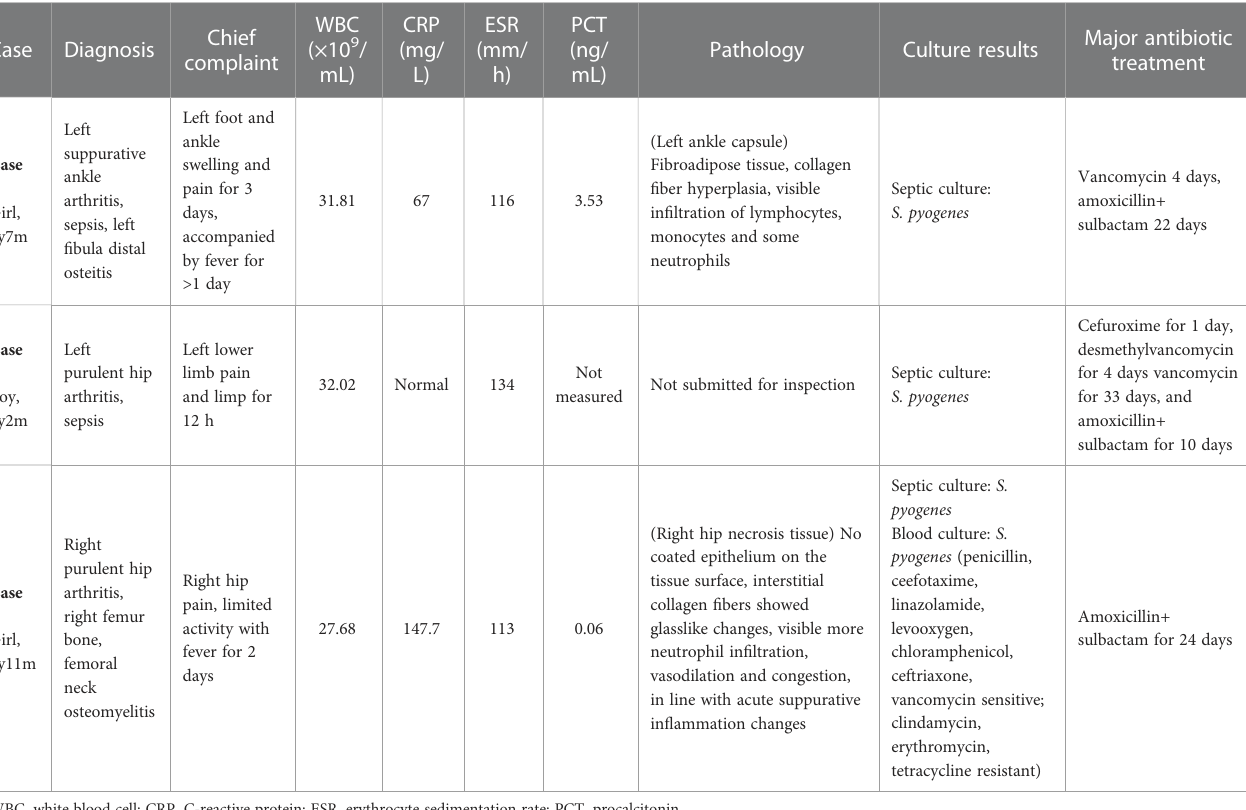
TABLE 1 Clinical data of three pediatric cases of septic arthritis caused by Streptococcus pyogenes .